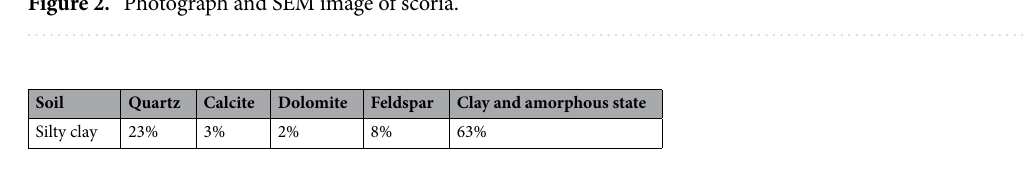
Figure 2. Photograph and SEM image of scoria.